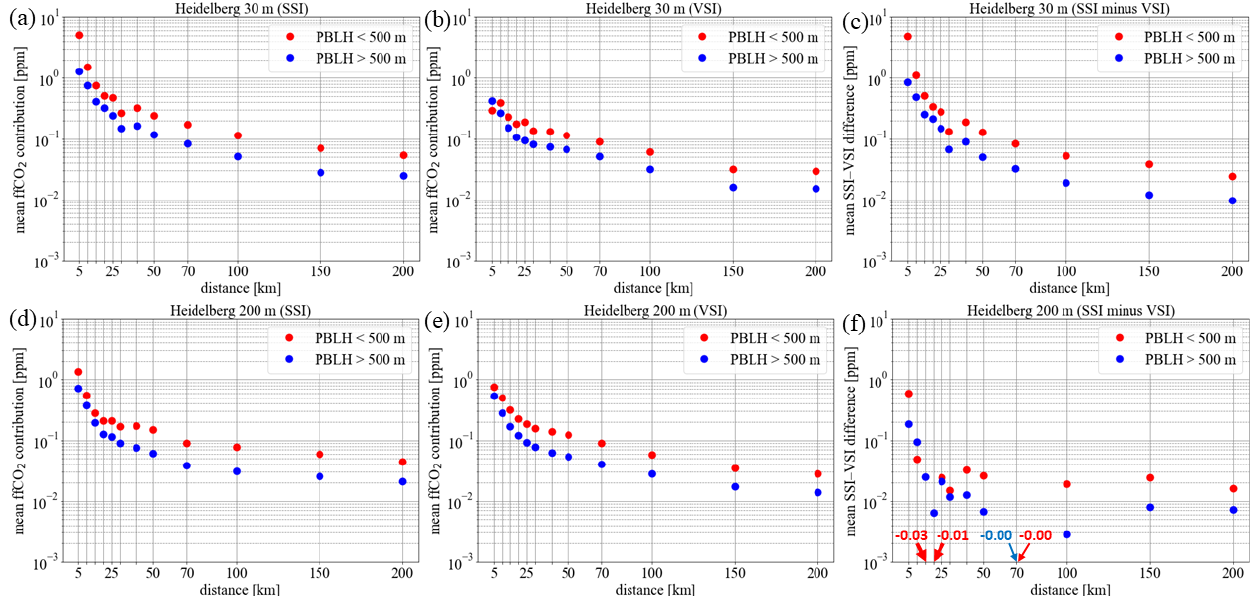
Figure 7. Mean ffCO 2 contributions from pseudo power plants, which were placed at distances between 5 and 200km from the observation site Heidelberg at 30m ( a–c ) and at a virtual 200m height ( d–f ). Shown are the results from the SSI ( a and d ) and VSI approach when using the TNO public power (energy) profile ( b and e ), as well as the mean difference between the SSI and VSI ffCO 2 contributions ( c and f ). From all hours in 2019, only those situations were selected for which each pseudo power plant grid cell is hit by at least 1 of the 100 back-trajectories, which were calculated for each hour. These selected hours are then divided into two planetary boundary layer height (PBLH) regimes (blue and red) and averaged. For this, we always used the PBLH at the Heidelberg measurement site at the time when the air parcels from the power plants arrived in Heidelberg. In (f) , negative values are indicated with red (PBLH < 500m) and blue (PBLH > 500m)